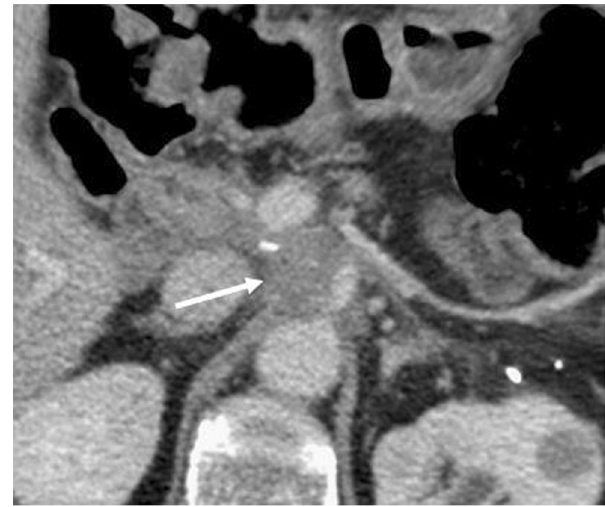
Fig. 28 Tumour recurrence. Axial CT image shows the presence of hypodense soft tissue (white arrow) consistent with tumour recurrence, encasing the origin of the caeliac trunk and portal vein